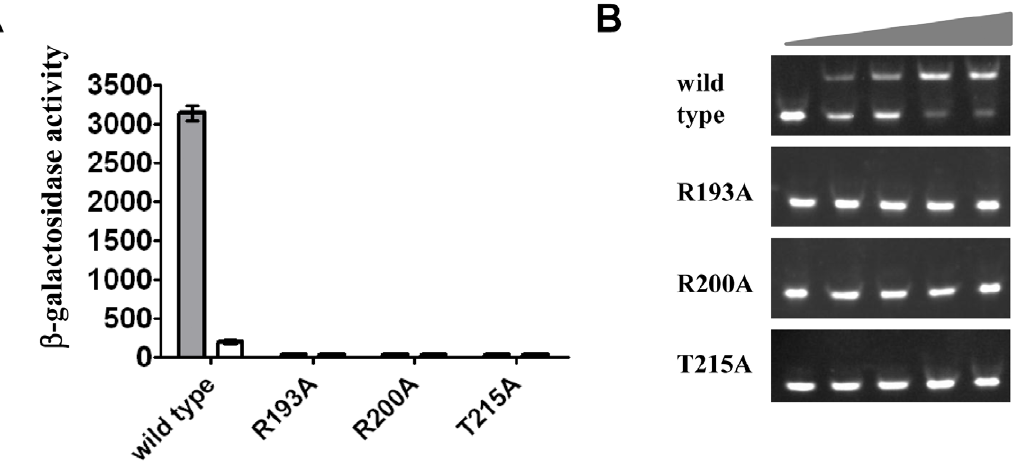
Figure 3. Effects of mutation of residues conserved in kdpE DBD . A. Comparison of b -galactosidase activities of KdpE mutants and wild-type KdpE in the kdpFABC Pro -lacZ fusion strain HAK003. Residues located in the a -8 (R193 and R200) and b -hairpin (T215) of KdpE (see Fig. 2) were targeted for mutagenesis to alanine. b -galactosidase (a reporter for kdpFABC expression) was measured in cells grown in media containing either K10 (white bar, 10 mM K + ) or K0 (gray bar, 0 mM K + ). B. EMSA showing effects of mutations in KdpE on interaction with the 30 bp DNA fragment representing its binding site. The triangles represent increasing molar ratios of 1:0, 1:1, 1:2, 1:4, and 1:8 of DNA to purified mutants as indicated and wild-type KdpE DBD .